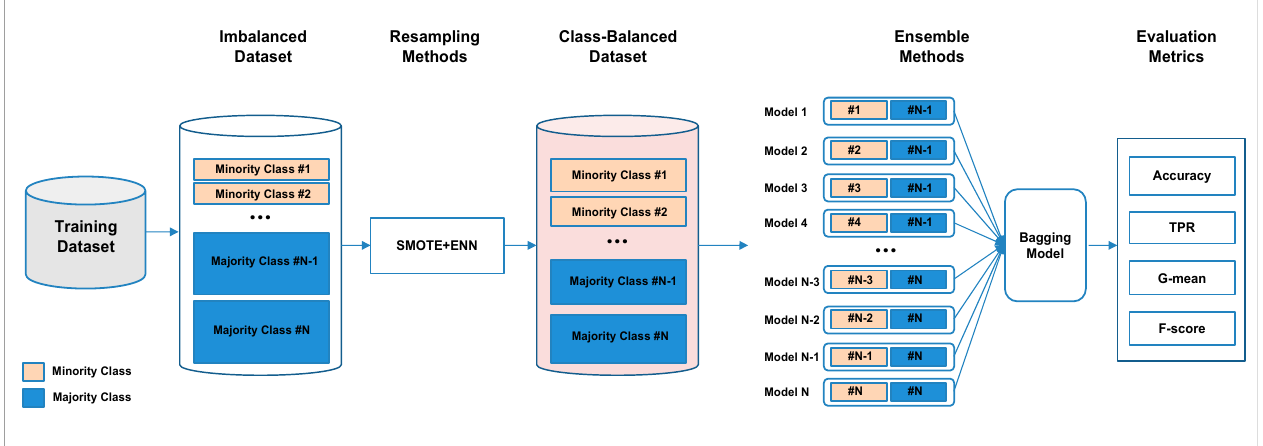
Figure 2. Ensemble mixed sampling method.